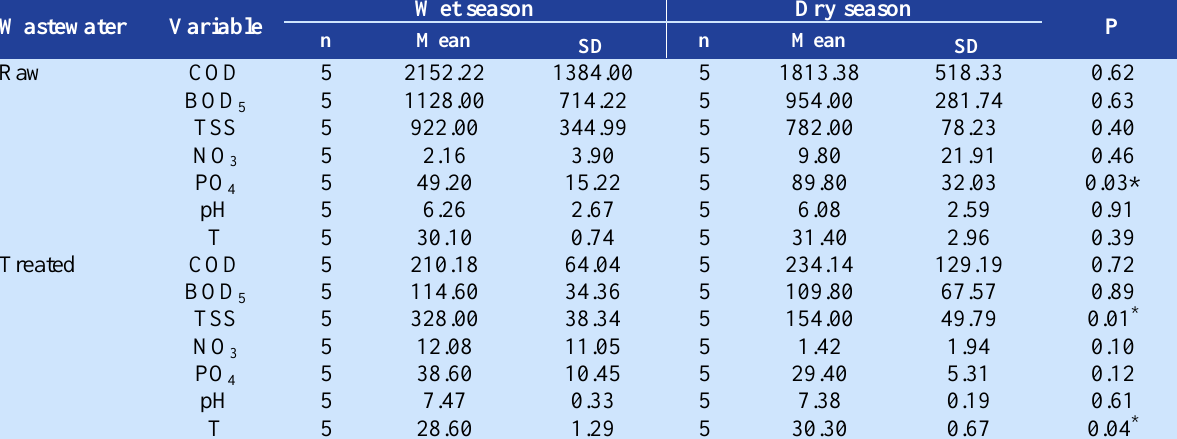
Table 1. Comparison of characteristics of raw and treated wastewater samples collected from Pelareh Dairy Industry in different